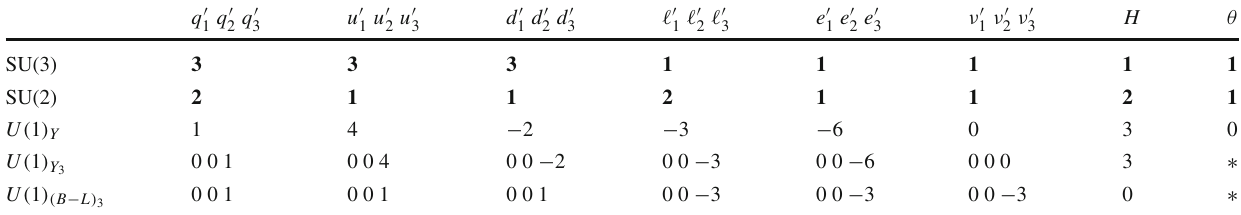
Table 2 Representations of fields under the SM gauge factors, which are family universal, together with the family non-universal Y 3 and ( B − L ) 3 symmetries on which our Z (cid:3) model is